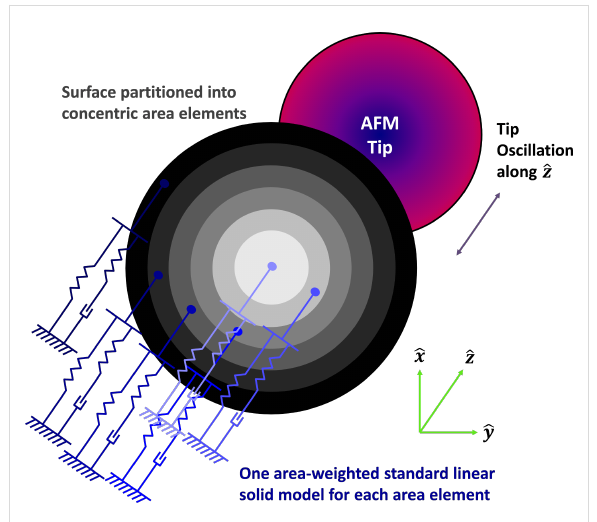
Figure 3: Illustration of the proposed model for a spherically symmetric AFM tip oscillating along the z -axis. Each concentric ring element is connected to an individual SLS model, whose parameters are propor- tional to the area of the